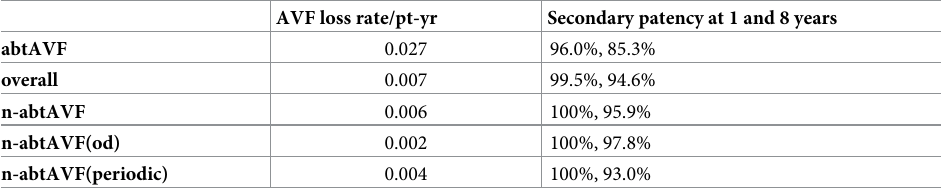
Table 4. The AVF loss rate and secondary patency of the target follow-up